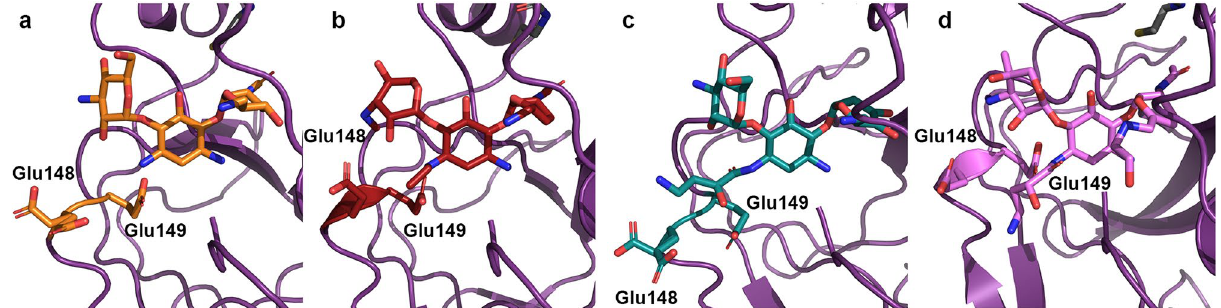
Figure 7. AAC(2 ′ )-Ia residues responsible for aminoglycoside N-1 (S)-HABA group accommodation. Residues are colored according to the corresponding aminoglycoside; ( a ) tobramycin, ( b ) netilmicin, ( c ) amikacin, and ( d ) plazomicin. Colors are in accordance with the schemes presented in Figs. 3 and